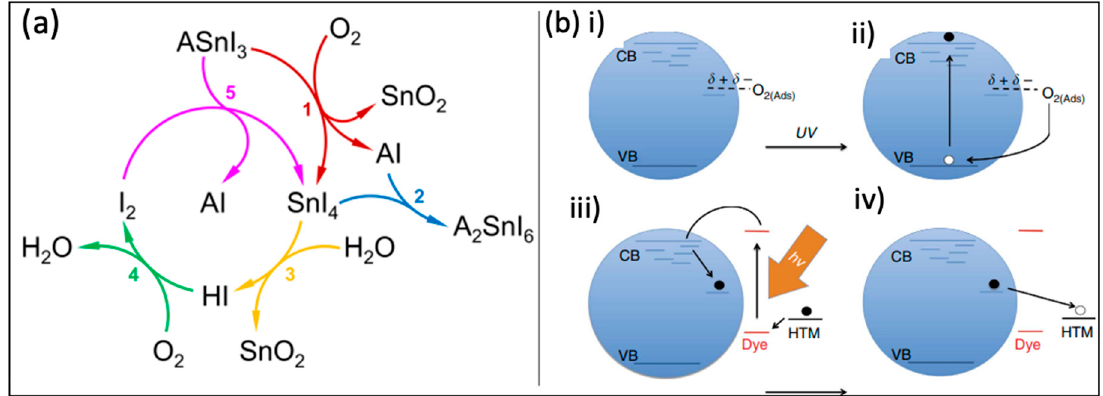
Figure 4. ( a ) Cyclic degradation of tin iodide perovskite in the presence of humid air in which reaction 1 is the oxidation of ASnI 3 By O 2 , reaction 2 is the solid-state formation of A 2 SnI 6 , reaction 3 is the hydrolysis of SnI 4 by H 2 O, reaction 4 is the oxidation of HI By O 2 , and reaction 5 is the oxidation of perovskite by I 2 . Reproduced under terms of CC-BY [65]. Copyright 2021, Nature publishing group. ( b ) Proposed ultraviolet light degradation process when photo-generated holes are applied externally with oxygen, after which they react with oxygen radicals adsorbed on the surface of oxygen vacancies, as seen in ( i , ii ). As a result of the oxygen, deep surface traps remain unfilled, and each trap has a free electron. ( iii ) As a result of the sensitizer’s photoexcitation, electrons flow into the conduction band, where they are deeply trapped, or directly into the deep surface traps, and as a result of that the electrons are strongly trapped and they easily recombine with holes in the spiro-OMeTAD (2,2’,7,7’-Tetrakis[N,N-di(4-methoxyphenyl)amino]-9,9’-spirobifluorene) hole transporter layer ( iv ). Reproduced with permission [67]. Copyright 2013, Nature publishing group.